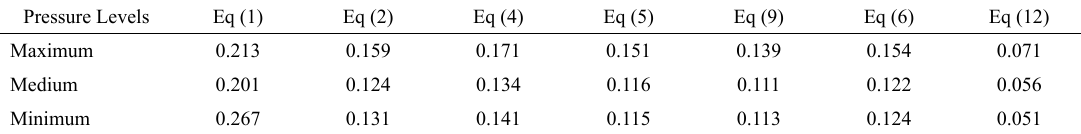
Table 4. Coefficient of friction calculated by different equations. Pressure Levels